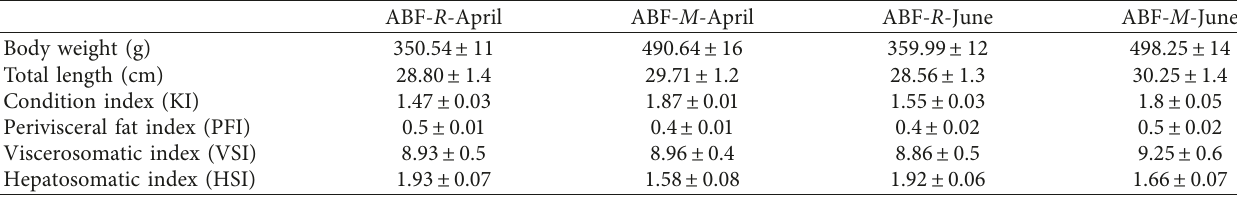
Table 1: Body weight, total length, and morphometric indices of the ABF sea bream sampled at different market sizes ( R and M ) and month (April and June).